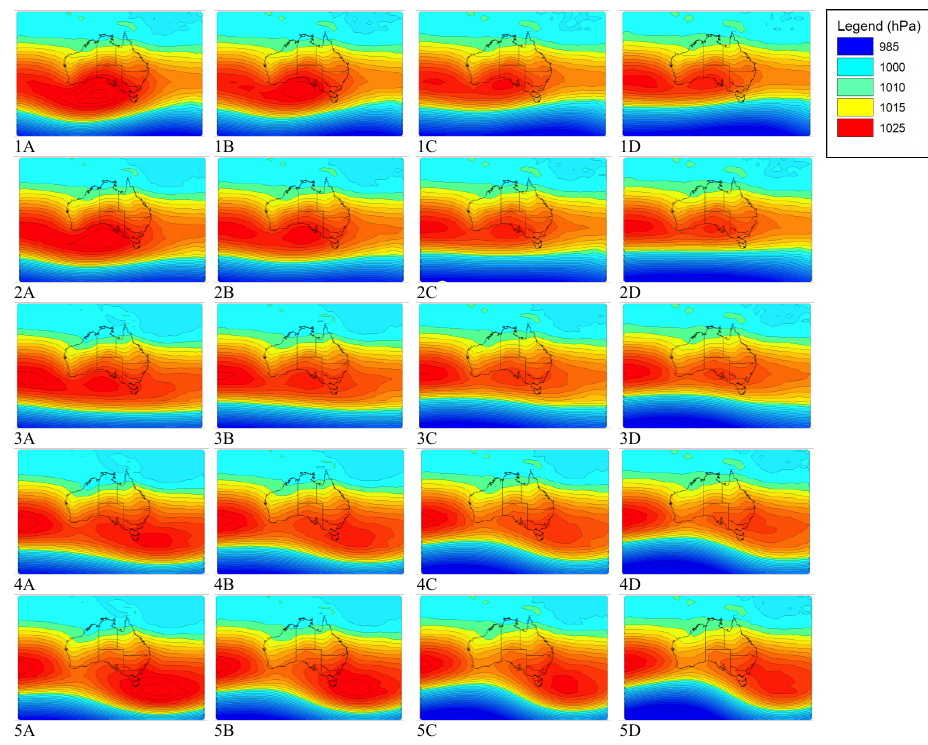
Figure 8. The 20 autumn synoptic types identified using SOM based on data from 1948–2009.